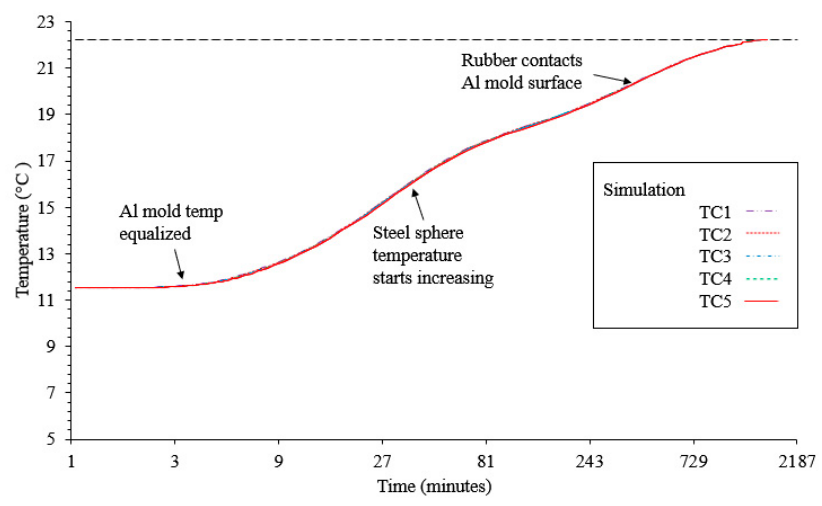
Figure 5. Through-thickness temperature distribution over time.